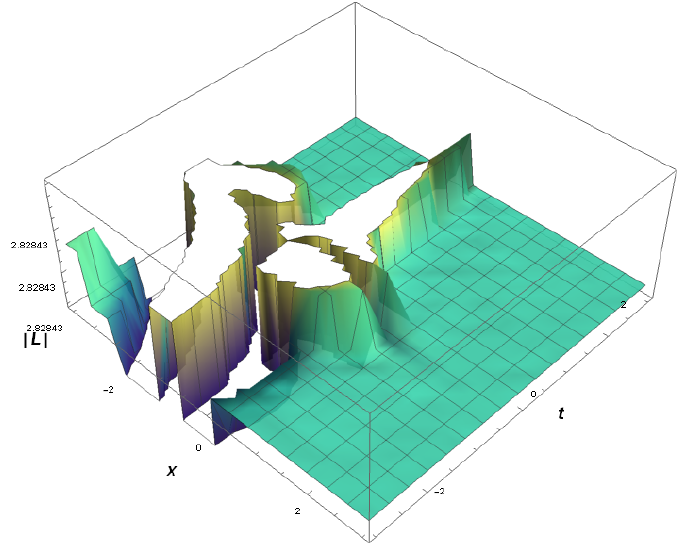
Figure 7. The 3D graph of dark–bright solitary-wave solutions, i.e., | L 18 | across β = 0.3. Figure 8: This illustration portrays a realistic representation of | L 31 ( t , x ) | which is linked to solitary-wave solutions. Here is a visual showing a 3D plot spanning the range ( − 0.8, 0.8 ) for various values of β associated with parameters, such as ρ = e , l = = 9, β = c = 1, α = − 1, s 1 = 1 , µ 1 = 1 , ζ 1 = 9, ν 2 1 2 4